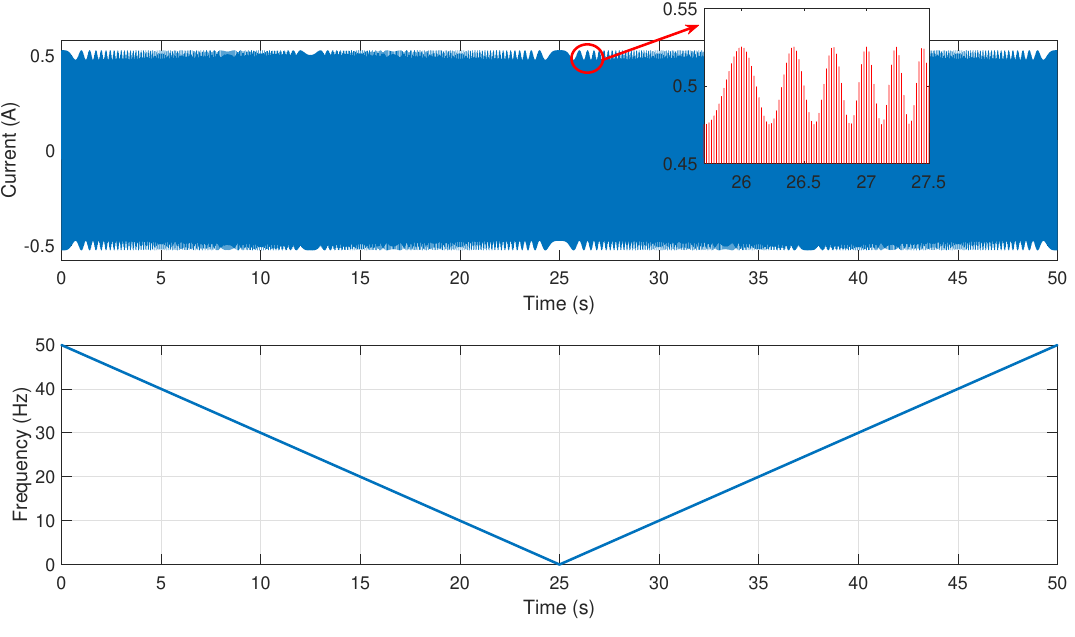
Figure 3. Synthetic current signal (17) used for illustrating the application of the proposed method ( top ). Frequency of the linear chirp component in the synthetic current signal (17) ( bottom